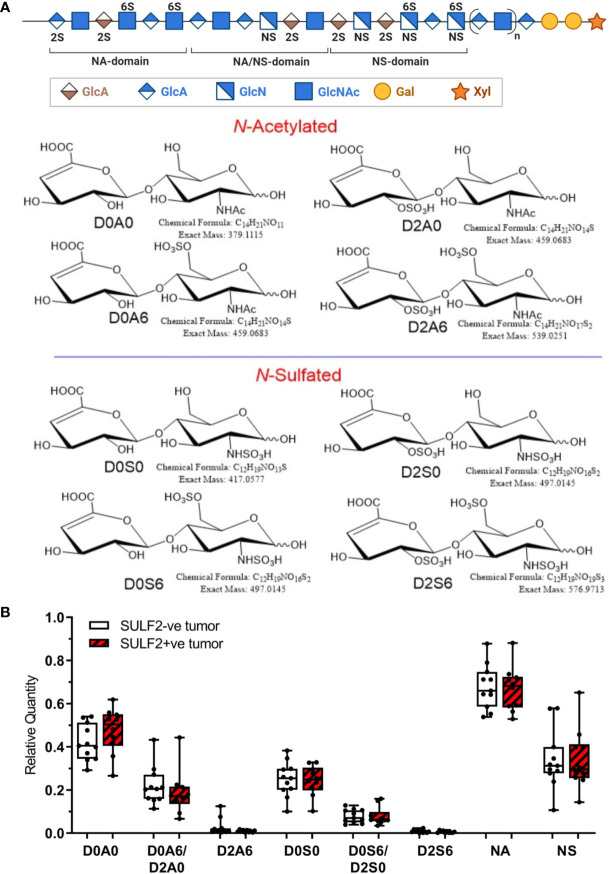
Sulfation pattern of HSPG in HNSCC tumor tissues. (A) Composition of HS chains represented by disaccharide units: one unsulfated disaccharide Δ4,5-uronic acid-N-acetylglucosamine (D0A0); three monosulfated disaccharides Δ4,5-uronic acid-N-acetylglucosamine-6-O-sulfate (D0A6), 2-O-sulfated Δ4,5-uronic acid-N-acetylglucosamine (D2A0), Δ4,5-uronic acid-N-sulfated glucosamine (D0S0); three disulfated disaccharides Δ4,5-uronic acid-N-sulfoglucosamine-6-O-sulfate (D0S6), 2-O-sulfated Δ4,5-uronic acid-N-sulfoglucosamine (D2S0), 2-O-sulfated Δ4,5-uronic acid-N-acetylglucosamine-6-O-sulfate (D2A6); one trisulfated disaccharide, 2-O-sulfated Δ4,5-uronic acid-N-sulfoglucosamine-6-O-sulfate (D2S6). (B) Relative quantity of the disaccharides detected in SULF2+ve tumors (n = 10) and SULF2-ve tumors (n = 11). NA represents the combined value of N-acetylated disaccharide units (D0A0, D0A6&D2A0, D2A6). NS represents the combined value of N-sulfated disaccharide units (D0S0, D0S6/D2S0, D2S6).